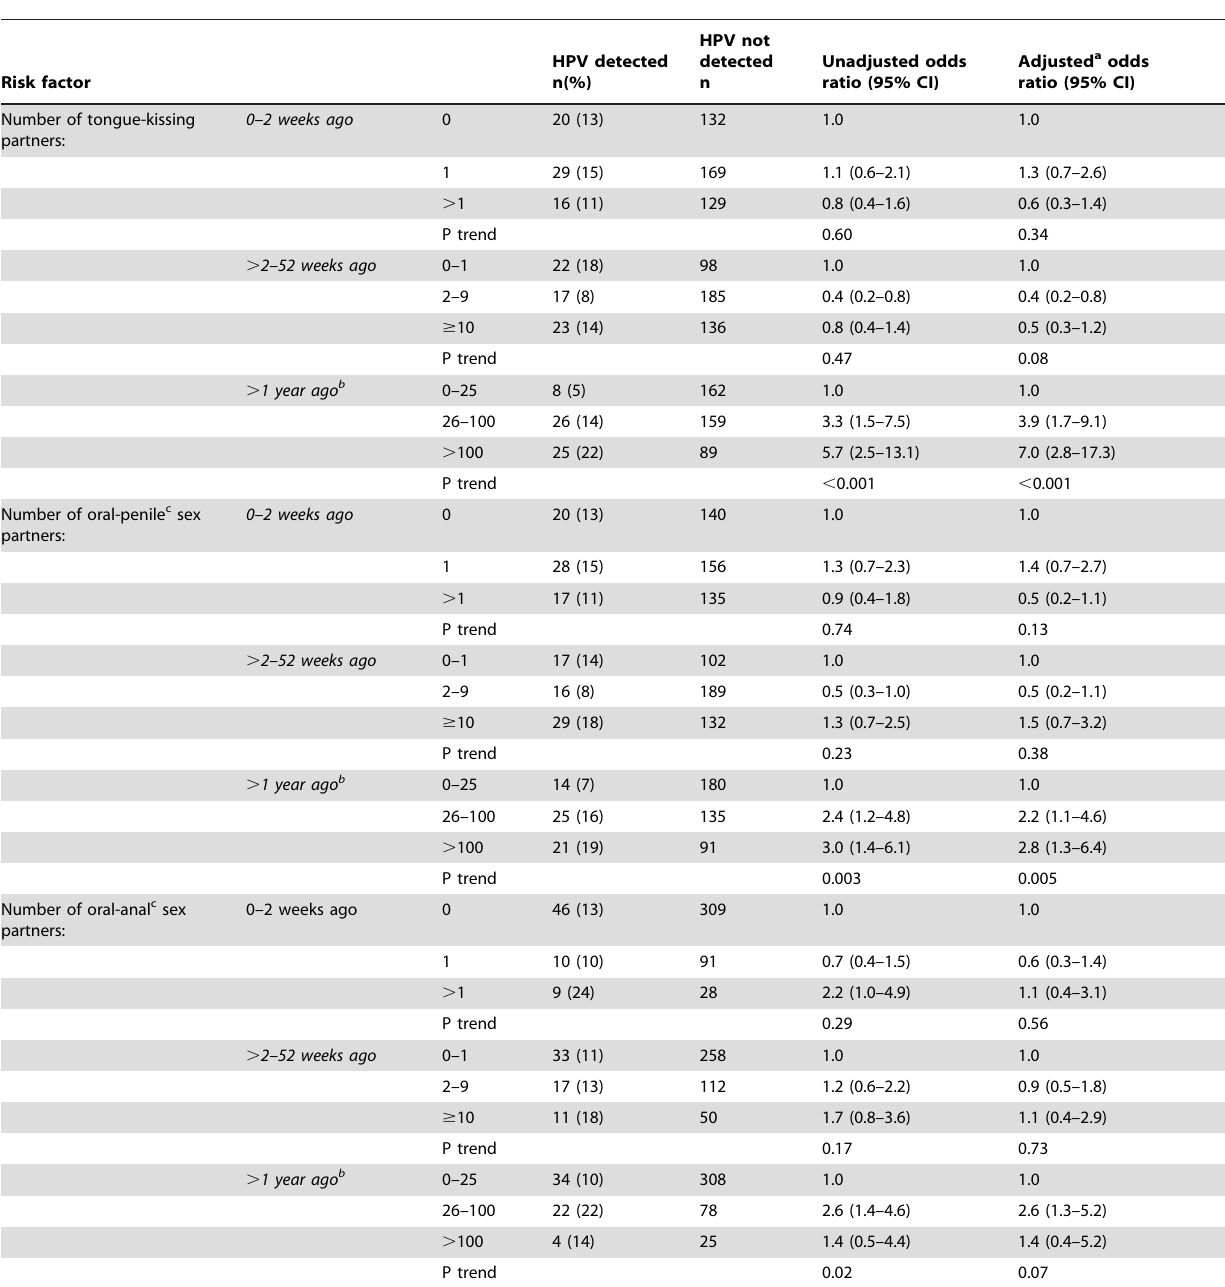
Table 3. Detection of oral HPV analysed by number of reported sexual partners for each sexual practice over three non- overlapping time